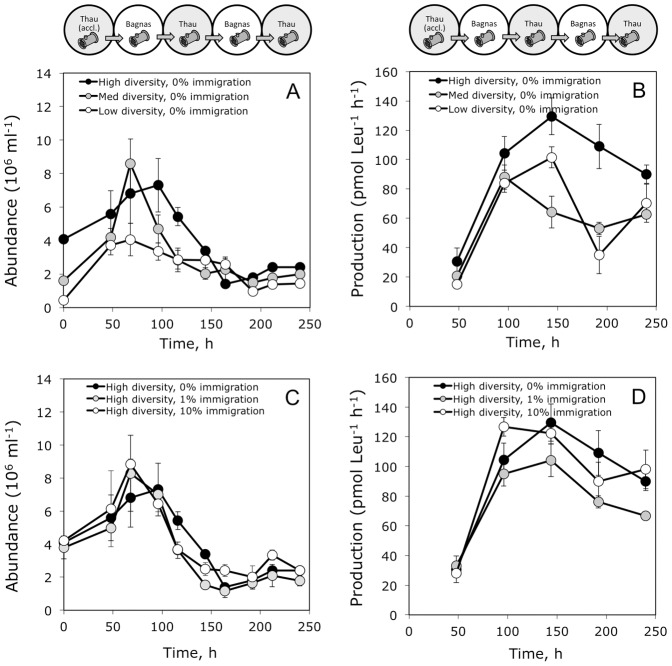
Bacterial growth within the diffusion chambers during the experiment.Bacterial abundance and production within chambers with (A, B) different levels of initial bacterioplankton diversity, in the absence of immigration, and with (C, D) different levels of bacterioplankton immigration at the high diversity level. The sketch above A and B is a reminder of the serial transfers between environments during the experiment (detailed in Fig 1). Error bars represent the standard deviation for three replicate chambers within each treatments.